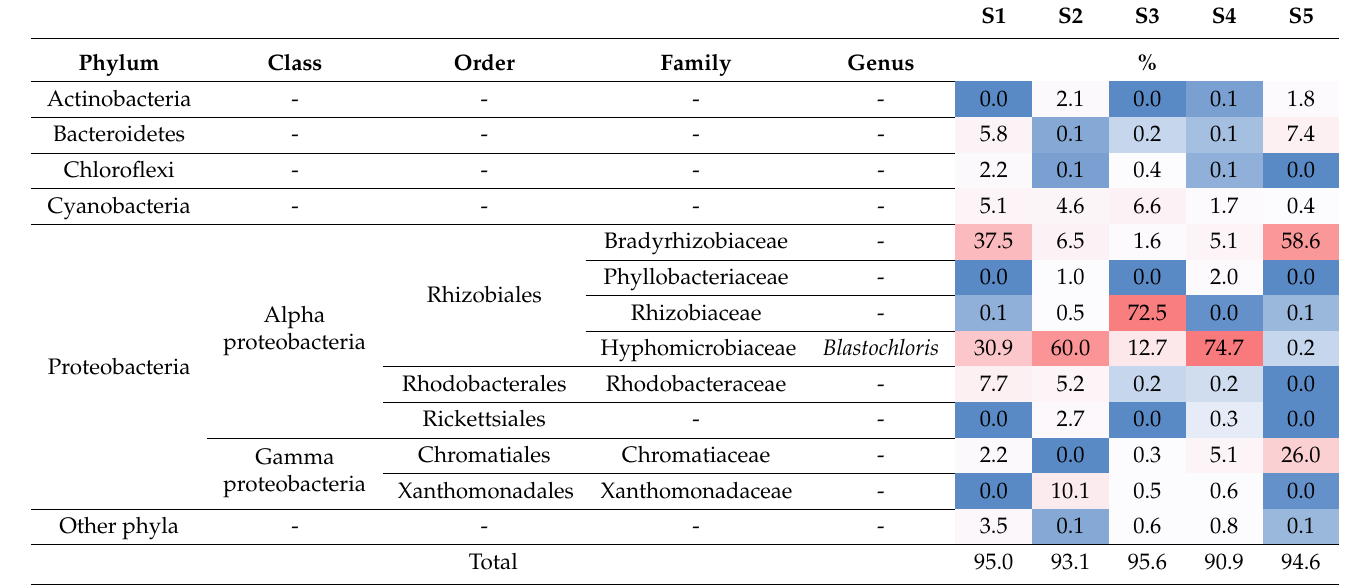
Table 2. Heatmap of the most abundant taxonomic groups ( ≥ 2% of abundance in at least one sample) identified in the PMCs fed with acetate synthetic medium less abundant to more abundant